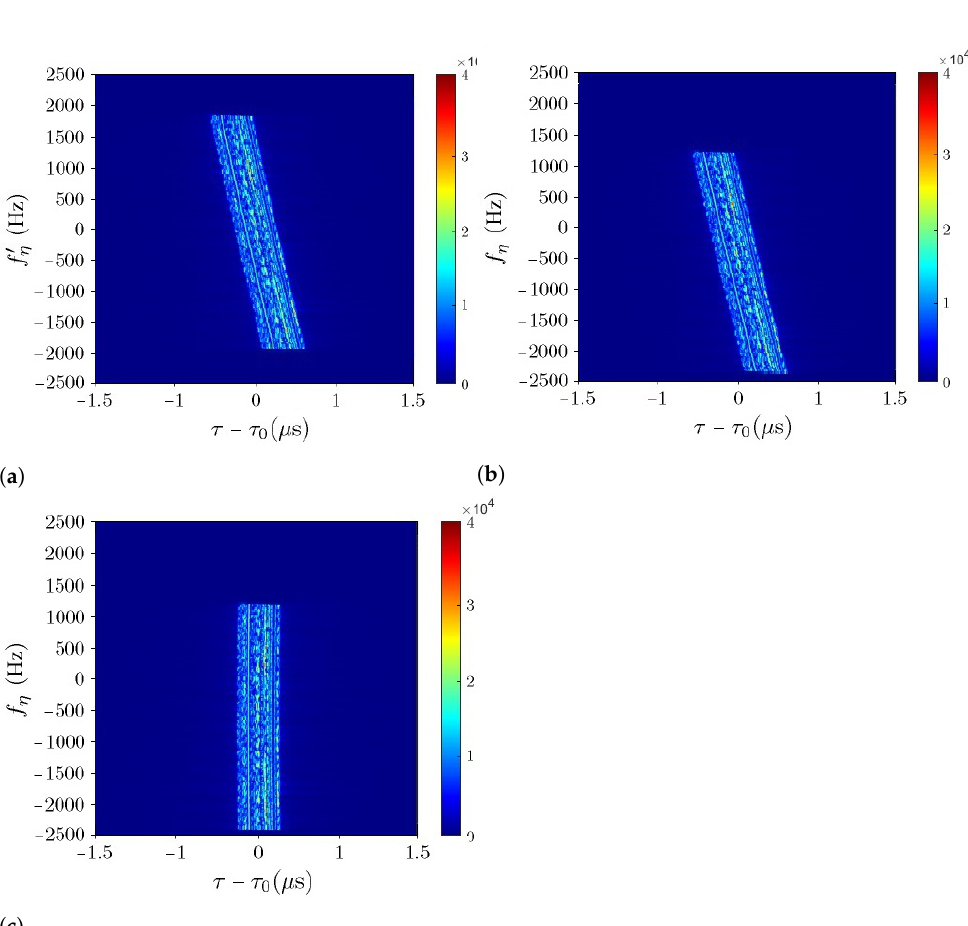
Figure 11. Magnitude of signals for imaging an Arleigh Burke-class destroyer, ( a ) S q spectrum after second RCMC, ( b ) S q ( τ , f η ) , Doppler spectrum after third S q 16